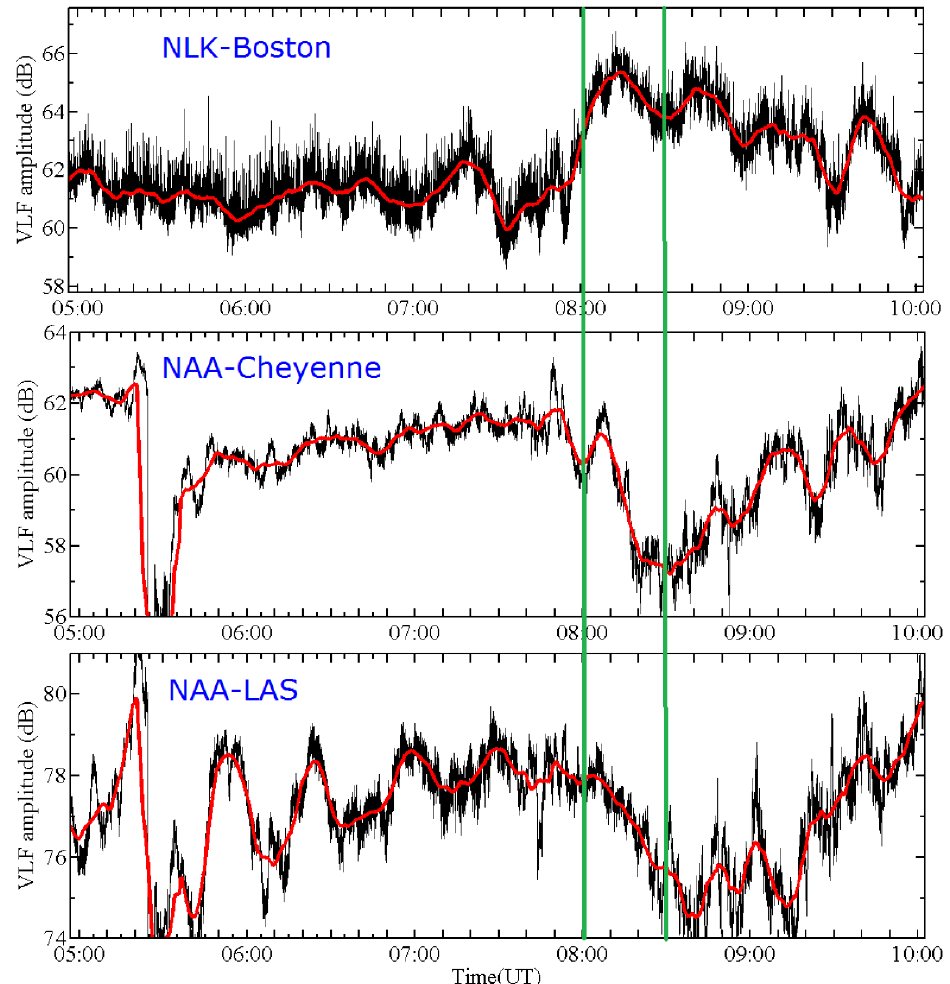
Figure 6. The black curves show the amplitude of VLF radio waves from 05:00 UT to 10:00 UT on 8 November 2004. The smoothing data is showed by red curves.